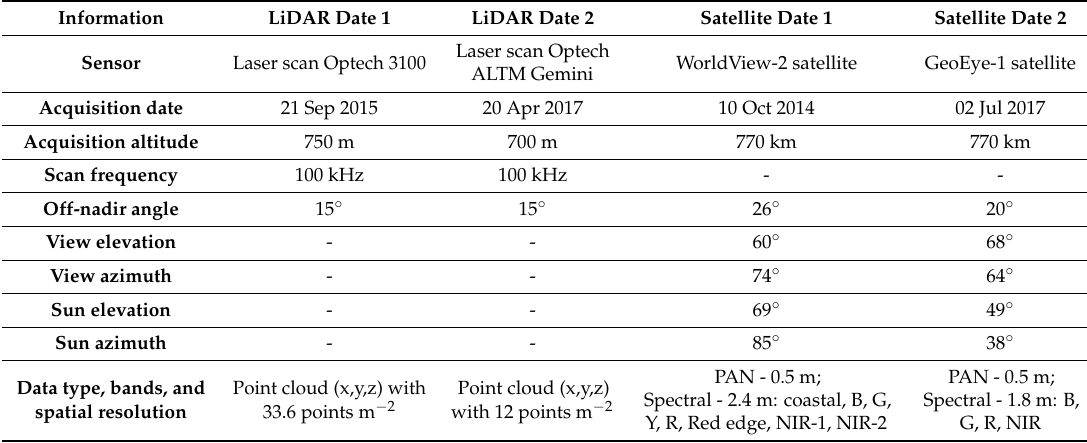
Table 1. Acquisition details of Airborne LiDAR and VHR satellite data used for tree loss